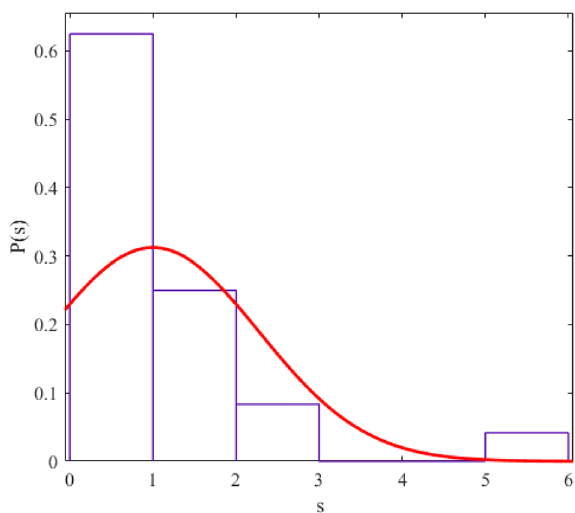
Figure 4. Similar to Fig. 1, the statistical distribution of 0